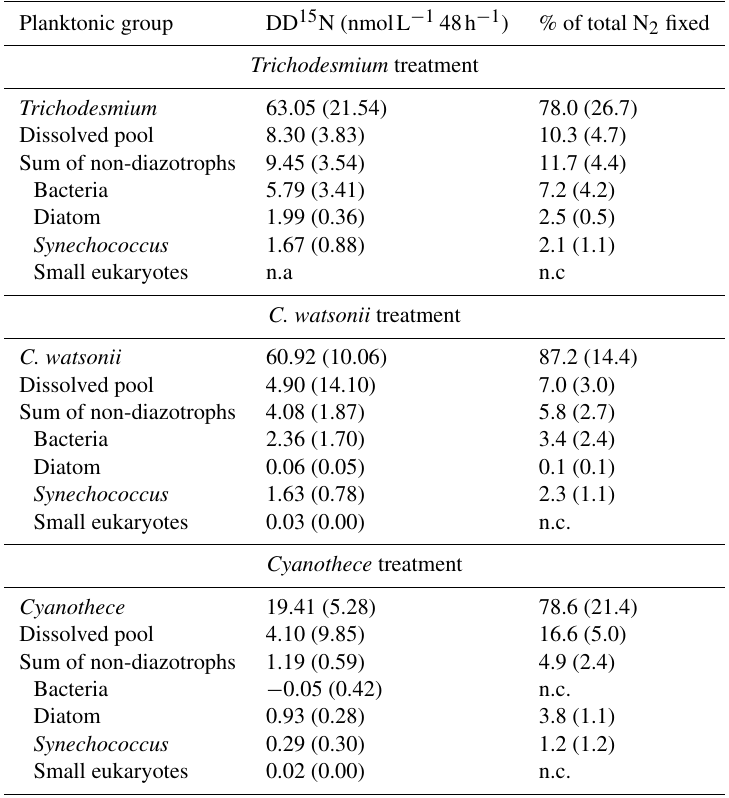
Table 1. Synthesis of the distribution of the recently fixed N 2 (DD 15 N) in each of the planktonic groups analysed after 48h of incuba- tion (nmolL − 1 48h − 1 ) and their respective proportion relative to the total fixed N 2 (%). n.a.: not analysed, n.c.: not calculated. Standard deviations are in